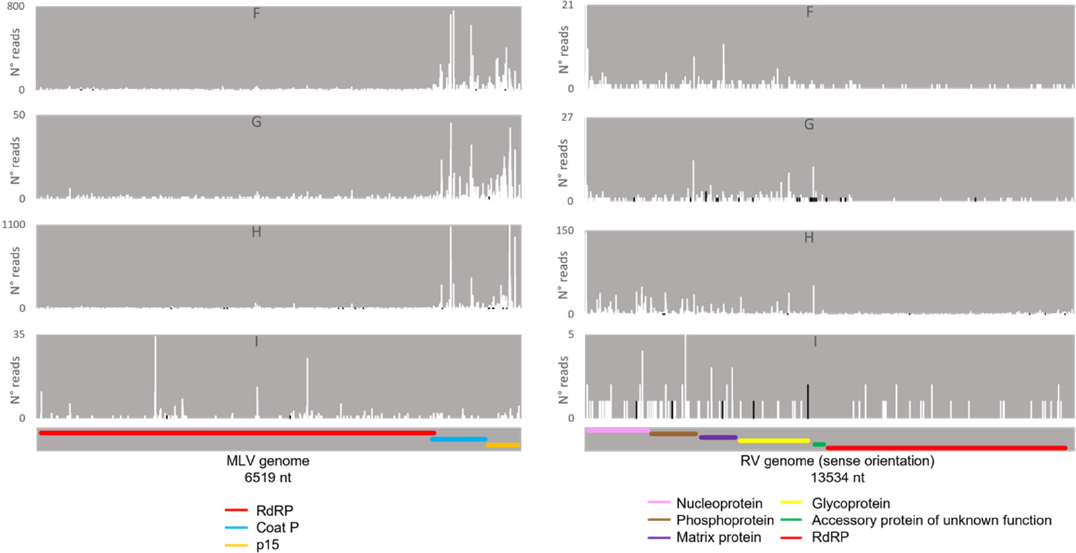
Figure 14. Distribution of 26–29 nt-long sRNAs bound to BmN4 Siwi, mapping to B. mori Macula-like Latent Virus (MLV) ( left ) and S. frugiperda Rhabdovirus (RV) ( right ). White bars: sense reads. Black bars: anti-sense reads. F–I: represented databases, listed in Table S2. Red: RdRp ORF; blue: coat P ORF; orange: p15 ORF; pink: nucleoprotein ORF; brown: phosphoprotein ORF; purple: matrix protein ORF; yellow: glycoprotein ORF; green: accessory protein of unknown function ORF.